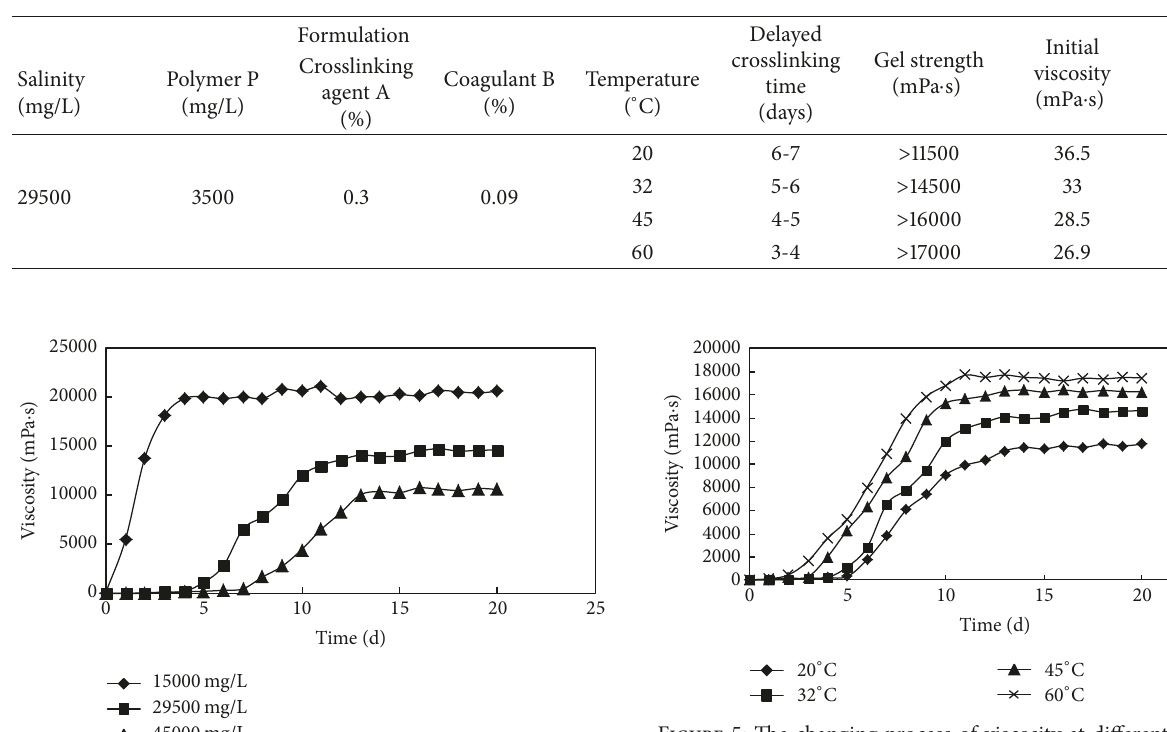
Table 3: The gelling performance of ABP system at different temperatures.